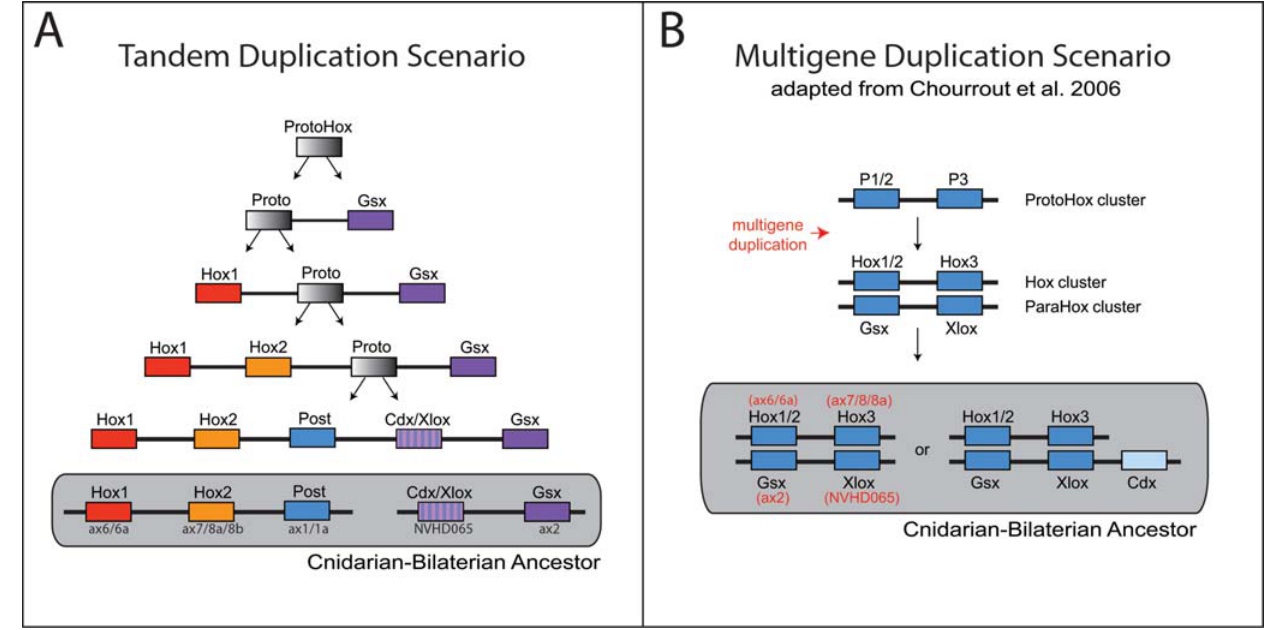
Figure 11. Origins of the Hox and ParaHox clusters. (A) The tandem duplication model of Hox and ParaHox clusters. Our evidence conflicts with the current theory that a multigene duplication event formed the Hox and ParaHox cluster. Under this alternative model, each Hox and ParaHox gene was formed through a series of tandem duplications either in the 3 9 or 5 9 direction and a translocation event separated the two ParaHox genes from the Hox cluster. Hox3 and Central Hox genes are not included in this model because it is not clear whether they were present in the cnidarian- bilaterian ancestor and subsequently lost in the Cnidaria or alternatively, were derived in the Bilateria from subsequent tandem duplication events of another Hox/ParaHox gene (for example anthox7/8a/8b or anthox1/1a). The general scenario presented here is robust enough to easily accommodate either event. (B) In this scenario adapted from Chourrout et al. 2006 Figure 3, a two-gene ProtoHox cluster is duplicated to form two sister clusters, the Hox and ParaHox clusters [51]. Chourrout et al. found that NVHD065 (Xlox/Cdx in their analysis) showed conflicting affinities for Xlox and Cdx; similarly our neighbor-joining and Bayesian trees had NVHD065 grouping with Cdx while the maximum-likelihood tree had NVHD065 grouping with Xlox. Unlike our study, Chourrout et al. considered anthox1 and anthox1a (HoxE and HoxF in their analysis) to be non-Hox/ParaHox lineages, hence their omission from their model [51].